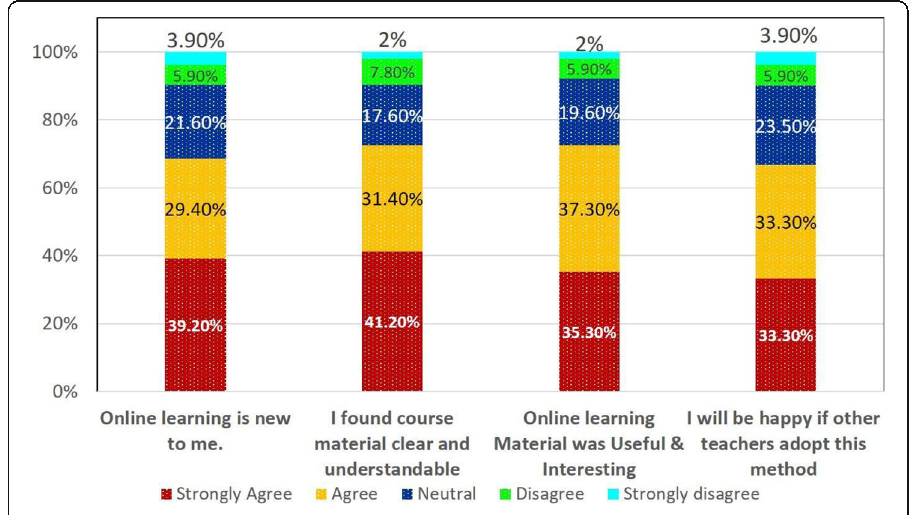
Fig. 10 Student ’ s perception of the usefulness of the